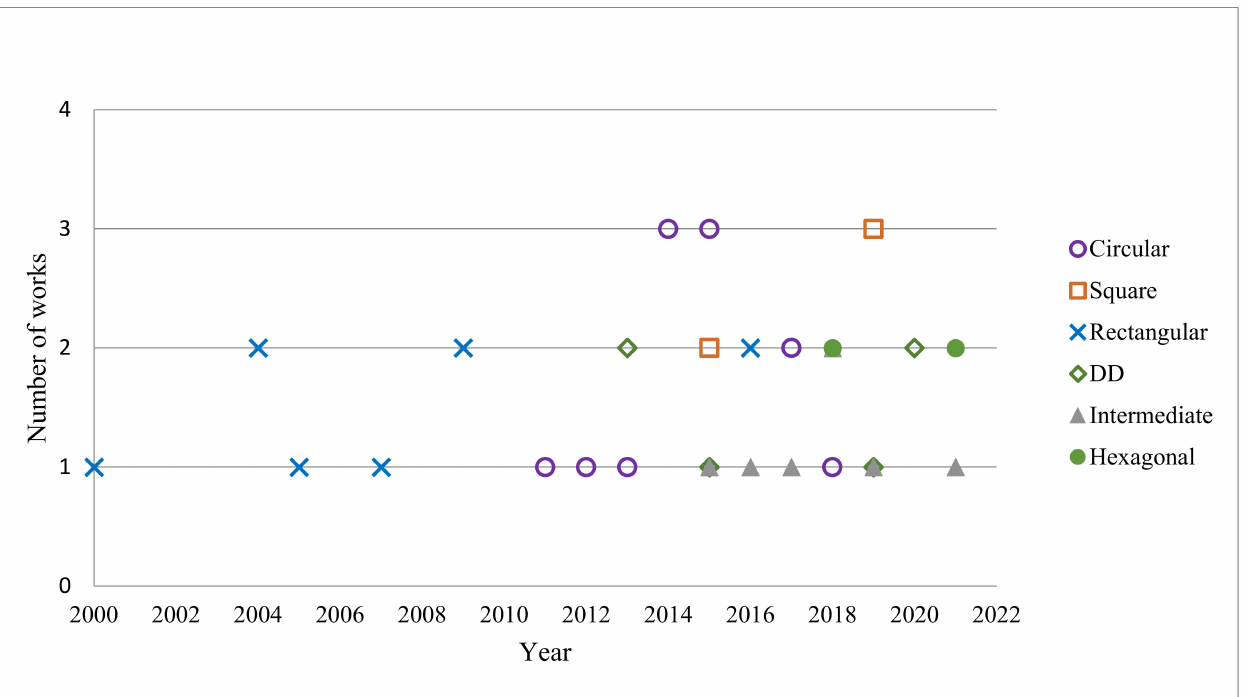
Figure 8. Number of works on coil structures used in academic studies by year of